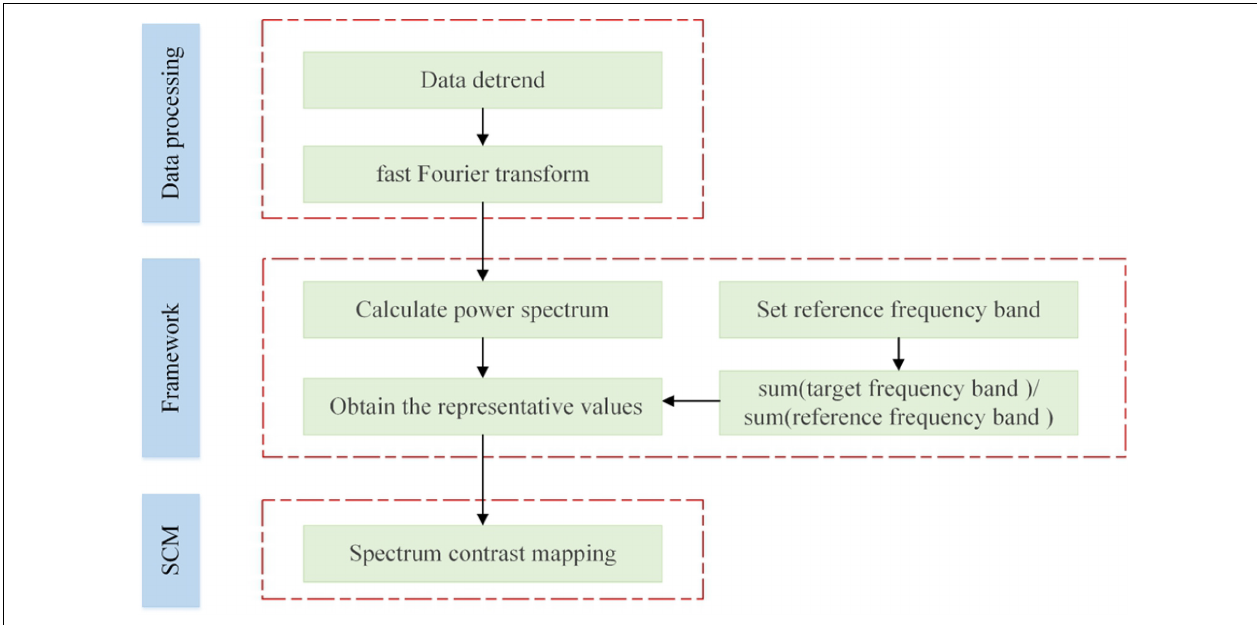
FIGURE 1 | The framework of the proposed SCM